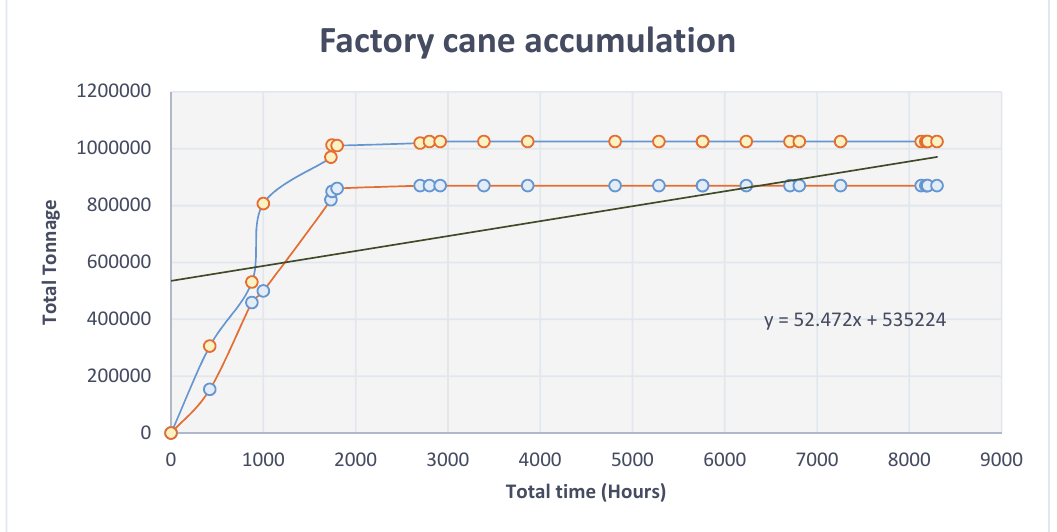
Fig. 16 (c) . The operating time and total deliveries with scheduling